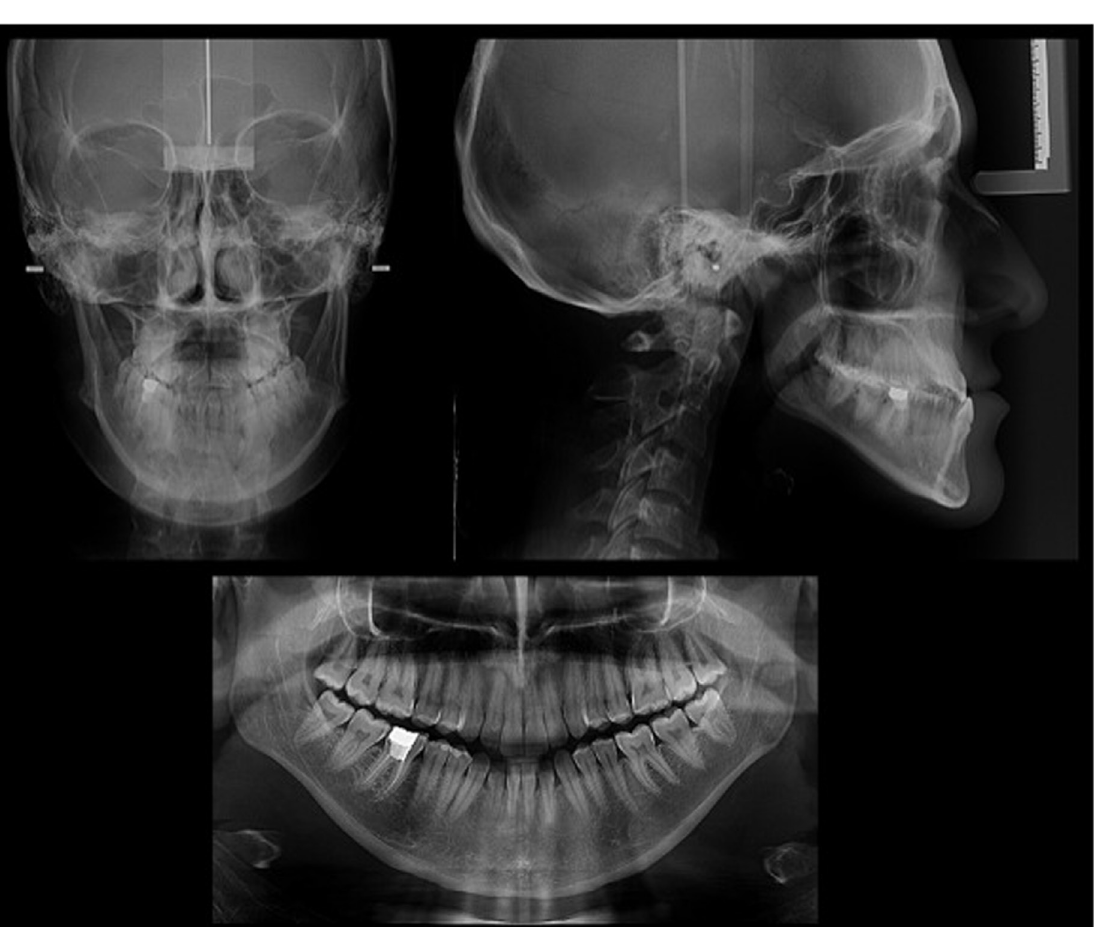
Figure 3. Pre-treatment posteroanterior cephalometric, lateral cephalometric and panoramic